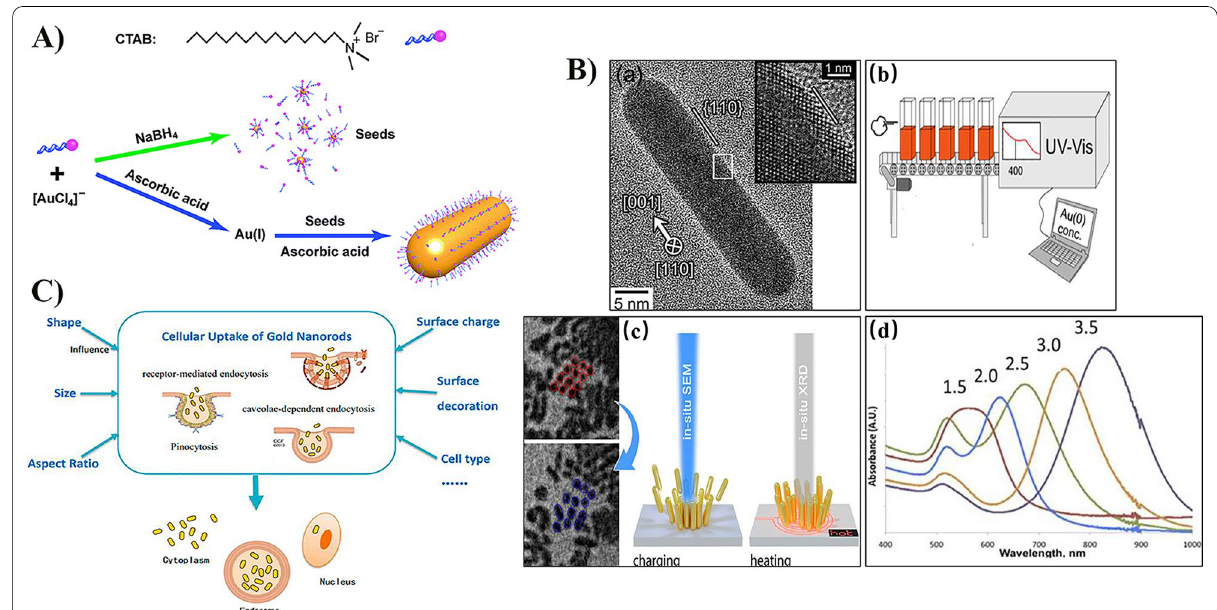
Fig. 2 Synthesis, characterization, and uptake of AuNRs. A Schematic illustration of the seed-mediated method for the growth of AuNRs. Reproduced with permission from Ref. [17]. Copyright 2013, Royal Society of Chemistry. B (a) The AuNRs intrinsic structure was characterized by high-resolution transmission electron microscopy as a single crystal along the [001] long axis. Reproduced with permission from Ref. [23]. Copyright 2019, Oxford University Press. (b) The UV–Vis absorbance of colloidal gold nanoparticles at 400 nm can determine Au concentrations in colloidal gold solutions. Reproduced with permission from Ref. [26]. Copyright 2014, ACS Publication. (c) A picture of the dynamics of vertically aligned assemblies of AuNRs. Reproduced with permission from Ref. [27]. Copyright 2020, ACS Publication. (d) UV–Vis-NIR extinction spectra of AuNRs with aspect ratios (AR) 1.5–3.5, AR are indicated above the absorbance spectrum of each sample. Reproduced with permission from Ref. [5]. Copyright 2021, Frontiers Media S.A. C Illustration of several factors affecting the cellular uptake of AuNRs. Reproduced with permission from Ref. [5]. Copyright 2021, Frontiers Media